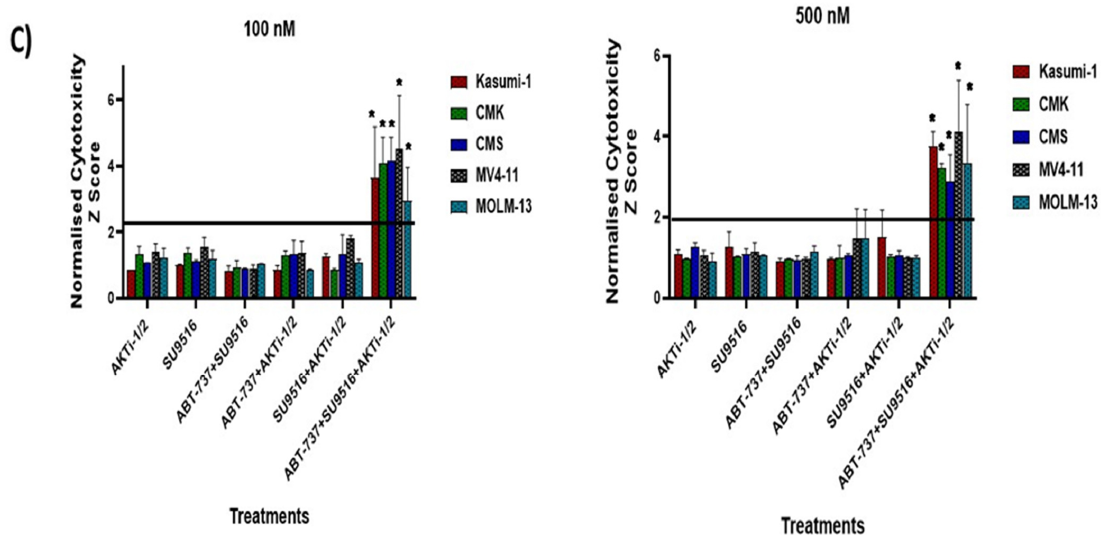
Figure 1. Secondary deconvolution screen of the 10 hit well into pairwise ( A , B ) triple combinations. The 10 compounds within this well were deconvoluted into 45 pairwise combinations and 120 triple combinations. The cytotoxicity of these combinations was tested over a period of 72 h at a final concentration of 0.1 and 0.5 μ M in Kasumi ‐ 1, MV4 ‐ 11, and CMK cells. Cells were treated with 0.1% DMSO as a vehicle control. Cell toxicity was assessed using the CellTox Green Cytotoxicity Assay, which was added to the cell suspension, and cells were incubated for 20 min at room temperature before reading. The relative fluorescence unit (RFU) (Ex: 485 nm, Em: 520 nm) was measured using a Synergy HTX Multi ‐ mode Microplate reader. The graphs demonstrate the Z ‐ score and are representative repeats of 3 independent screens. ( C ) Investigating the effects of the double combinations of the triple combination of ABT ‐ 737 + AKTi ‐ 1/2 + SU9516. The CellTox Green Cytotoxicity Assay was used to determine cell viability of the cell lines following 72 h treatment. The graphs demonstrate the Z ‐ score and are representative repeats of 3 independent screens. * = p < 0.05.